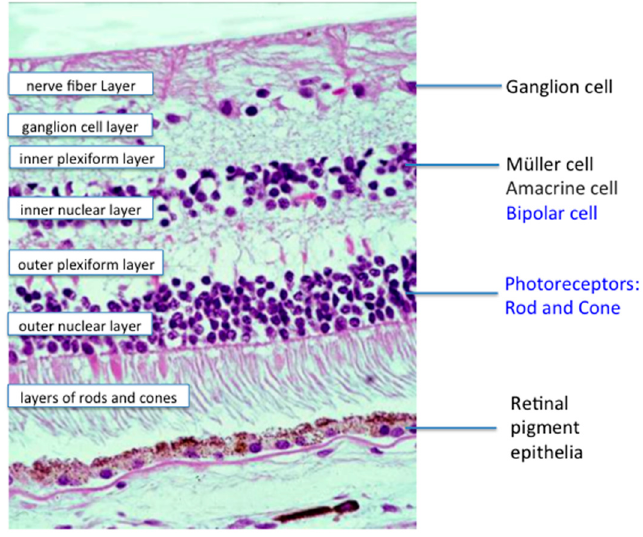
Figure 2. Histology of a normal retina. Retinal ganglion cell, Müller cell, and retinal pigment epithelia are the main stem cell of the retina. (hematoxylin & eosin, ×100).